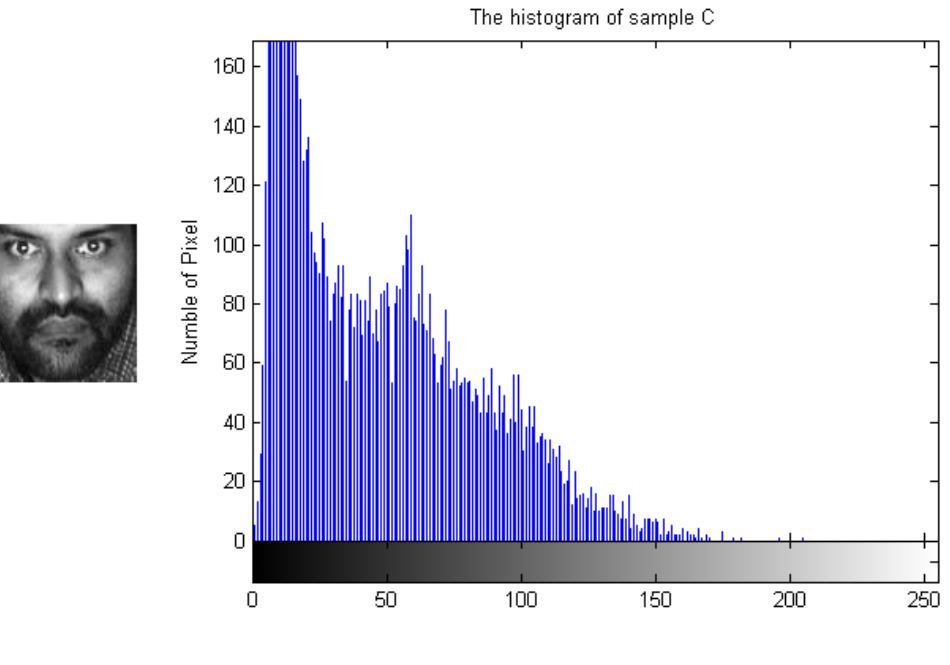
Figure 5. Sample C and its histogram.